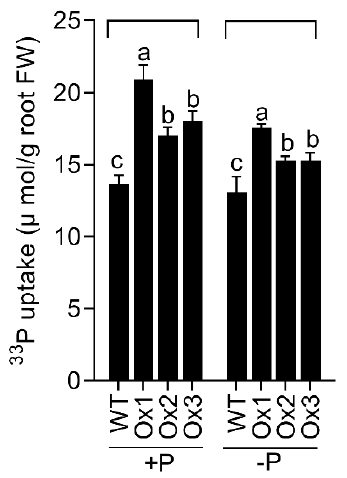
Figure 4. Overexpression of OsPHT1;4 increases 33 Pi uptake rate. WT and Ox1–Ox3 seedlings (10 days old) were grown hydroponically in +P and − P media for 1 week and then transferred to the respective media containing 33 Pi to incubate for 3 h. Roots were harvested to determine the 33 Pi uptake. Values are means ± SE ( n = 5). Different letters above the bars indicate significant differences ( p < 0.05, one-way ANOVA). FW: Fresh weight.